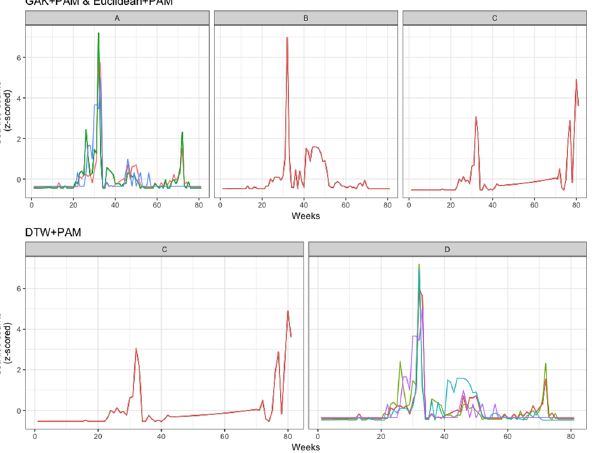
Fig 2. Farm I clustering for 2012-2013. Time-series plots for the most stable clustering algorithms for Farm I, production cycle of 2012-2013.